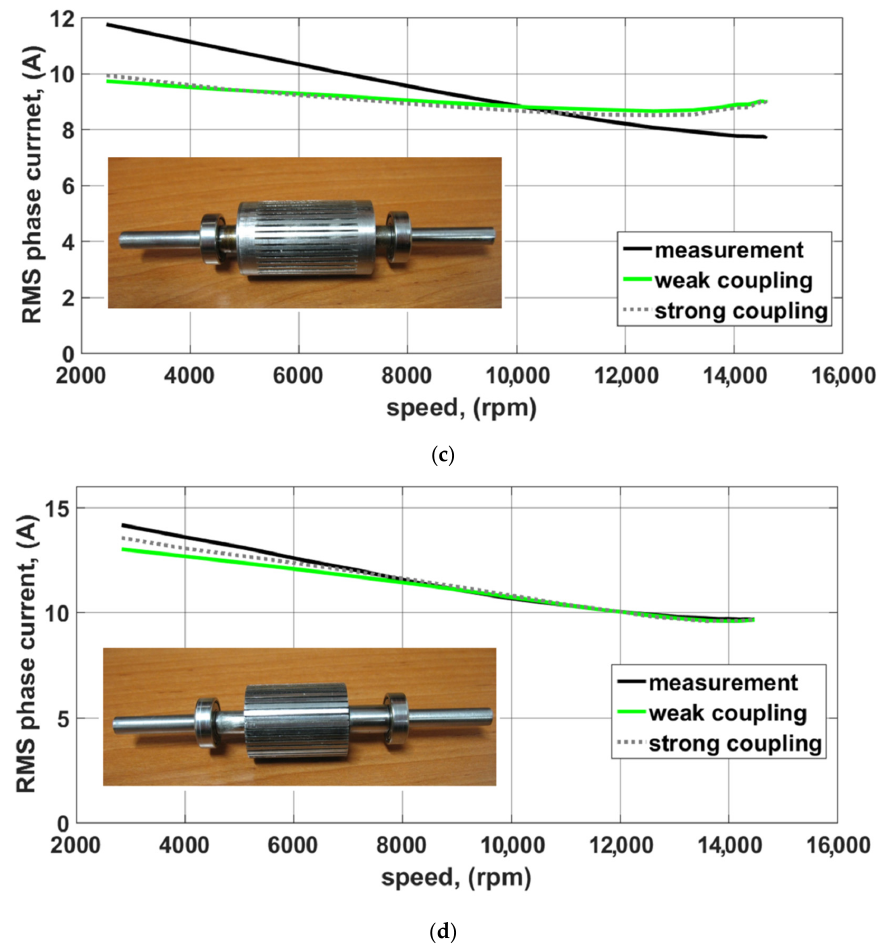
Figure 8. Comparison of calculation results with the multi-harmonic model with the weak coupling to those of calculations with the multi-harmonic model with the strong coupling, with the measurement results [17]. ( a ) Physical test-stand, ( b ) RMS current vs. rotor speed for the machine equipped with an uniform rotor, ( c ) RMS current vs. rotor speed for the machine equipped with a slitted rotor with uniform end regions, ( d ) RMS current vs. rotor for a machine equipped with a slitted rotor with slits through the whole